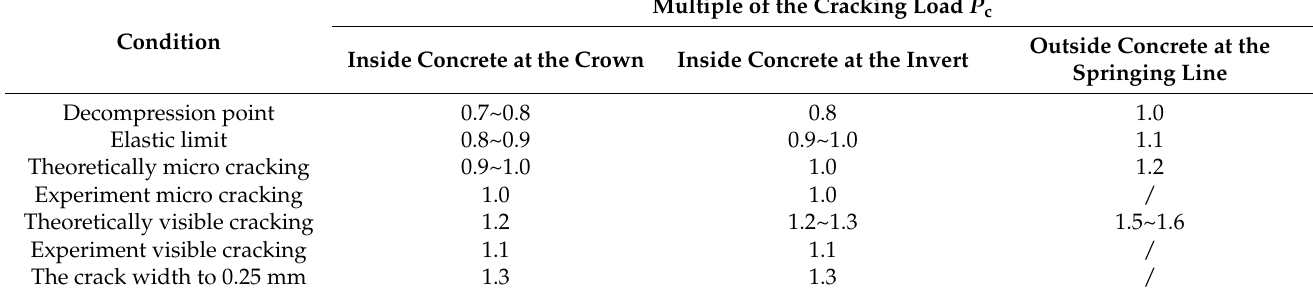
Table 7. Loads corresponding to different states of